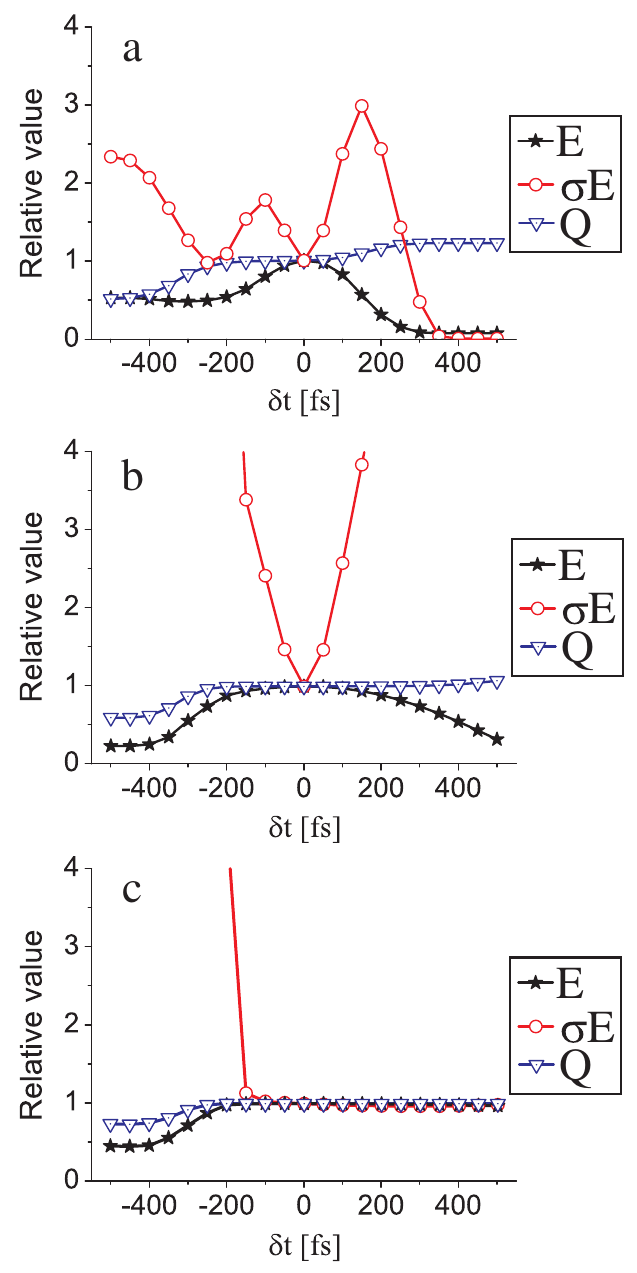
FIG. 9. (Color) Effect of (cid:1) 500 fs fluctuations in the timing between laser and electrons ( (cid:8)t > 0 means the electrons are injected further in front of the laser pulse) on the final beam parameters [energy ( E ), energy spread ( (cid:5)E ) and trapped fraction ( Q )] for the different injection regimes: a 0 ¼ 0 : 32 (a), a 0 ¼ 0 : 56 (b), and a 0 ¼ 1 : 02 (c) with injection 300 fs in front of the laser